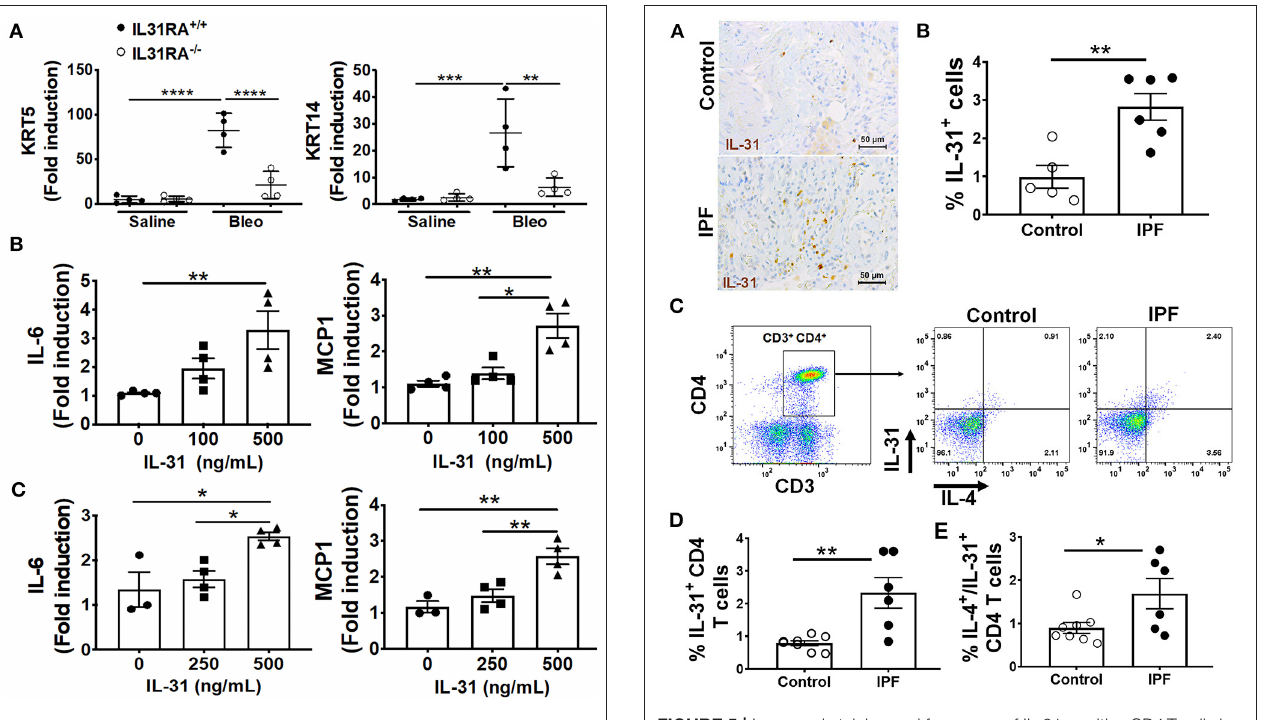
FIGURE 4 | The loss of IL-31RA signaling alters the expression of epithelial cell-specific gene expression during bleomycin-induced pulmonary fibrosis. (A) Reduced expression of epithelial cell-specific genes including KRT5 and KRT14 in the lungs during bleomycin-induced pulmonary fibrosis. (B) Bronchial epithelial cell line BEAS-2B was stimulated with recombinant IL-31 for 24h and the transcripts of MCP1 and IL-6 measured using RT-PCR. (C) primary normal human bronchial epithelial (HBEC) cells were stimulated with recombinant IL-31 for 24h and the transcripts of MCP1 and IL-6 measured using RT-PCR. Data presented as Mean ± SEM ( n = 4 mice/group). Statistical analysis was performed using one-way ANOVA with Tukey’s multiple comparisons test * p < 0.05; ** p < 0.01; *** p < 0.005; **** p < 0.001.